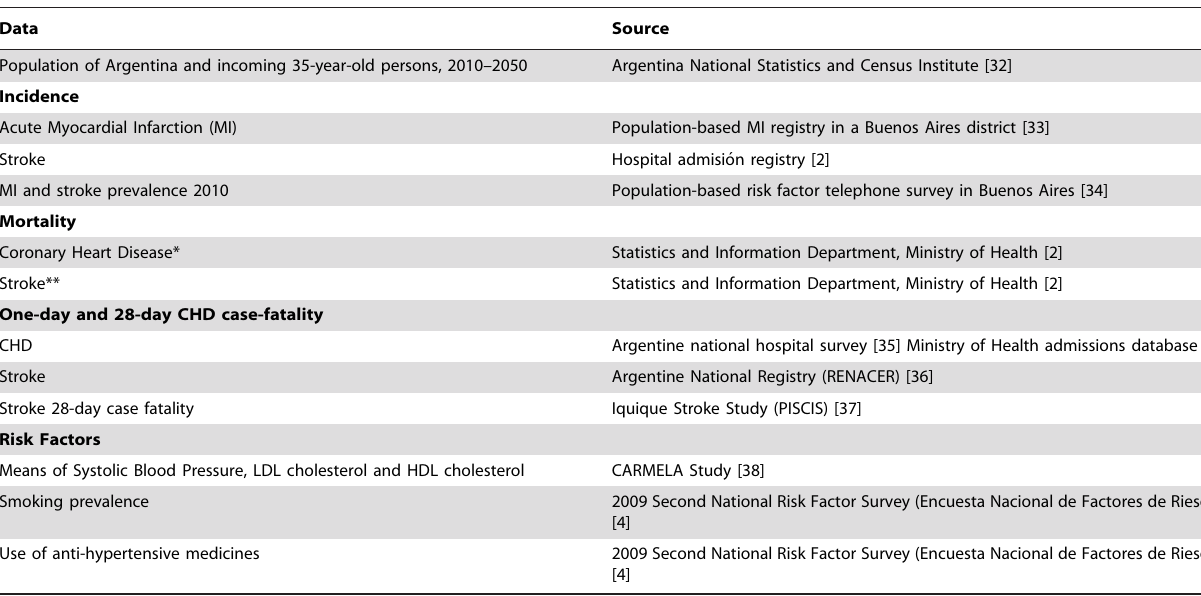
Table 1. Data sources for CVD policy